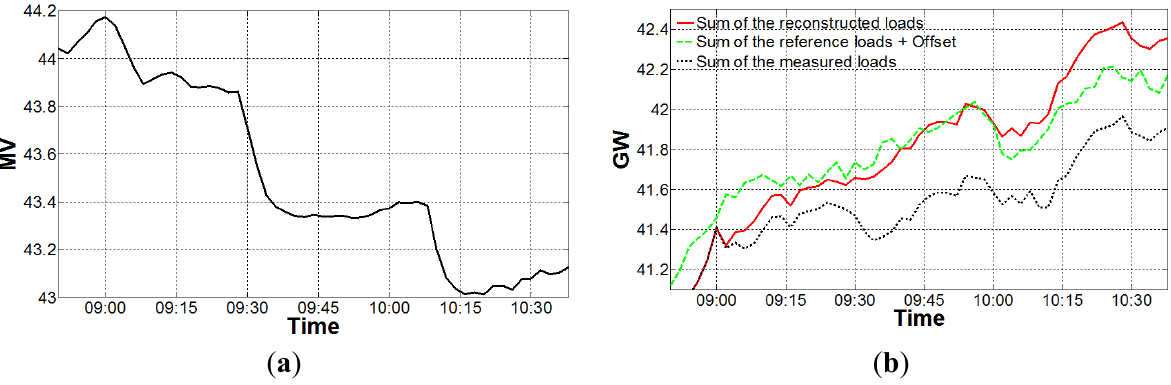
Figure 8. Results of the nationwide CVR implemented on 10 April 2013: ( a ) sum of 1913 bank voltages; and ( b ) sum of 1913 transformer-bank